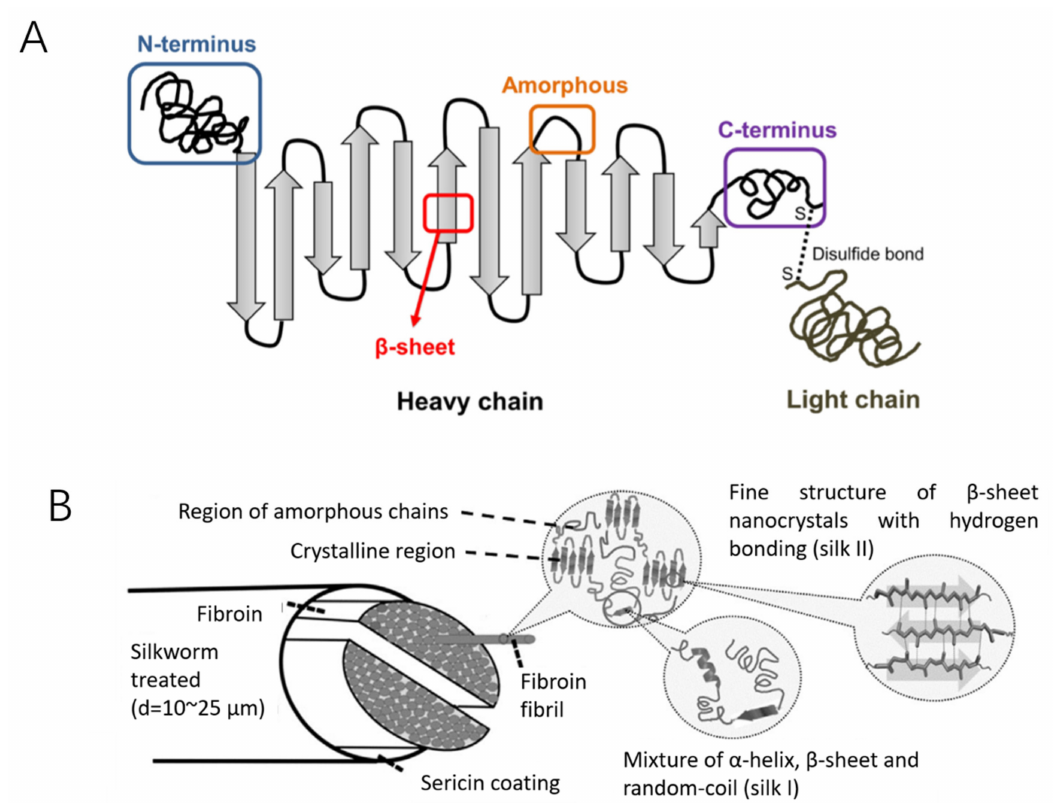
Figure 1. Schematic diagram of the silk structure. ( A ) heavy chain (i.e., N-terminus, β -sheets, Amorphous and C-terminus) and light chain which linked via disulphide bonds. Reproduced with permission from [40] ( B ) silkworm thread, fibril overall structure and silk fibroin polypeptide chains. reproduced with permission from